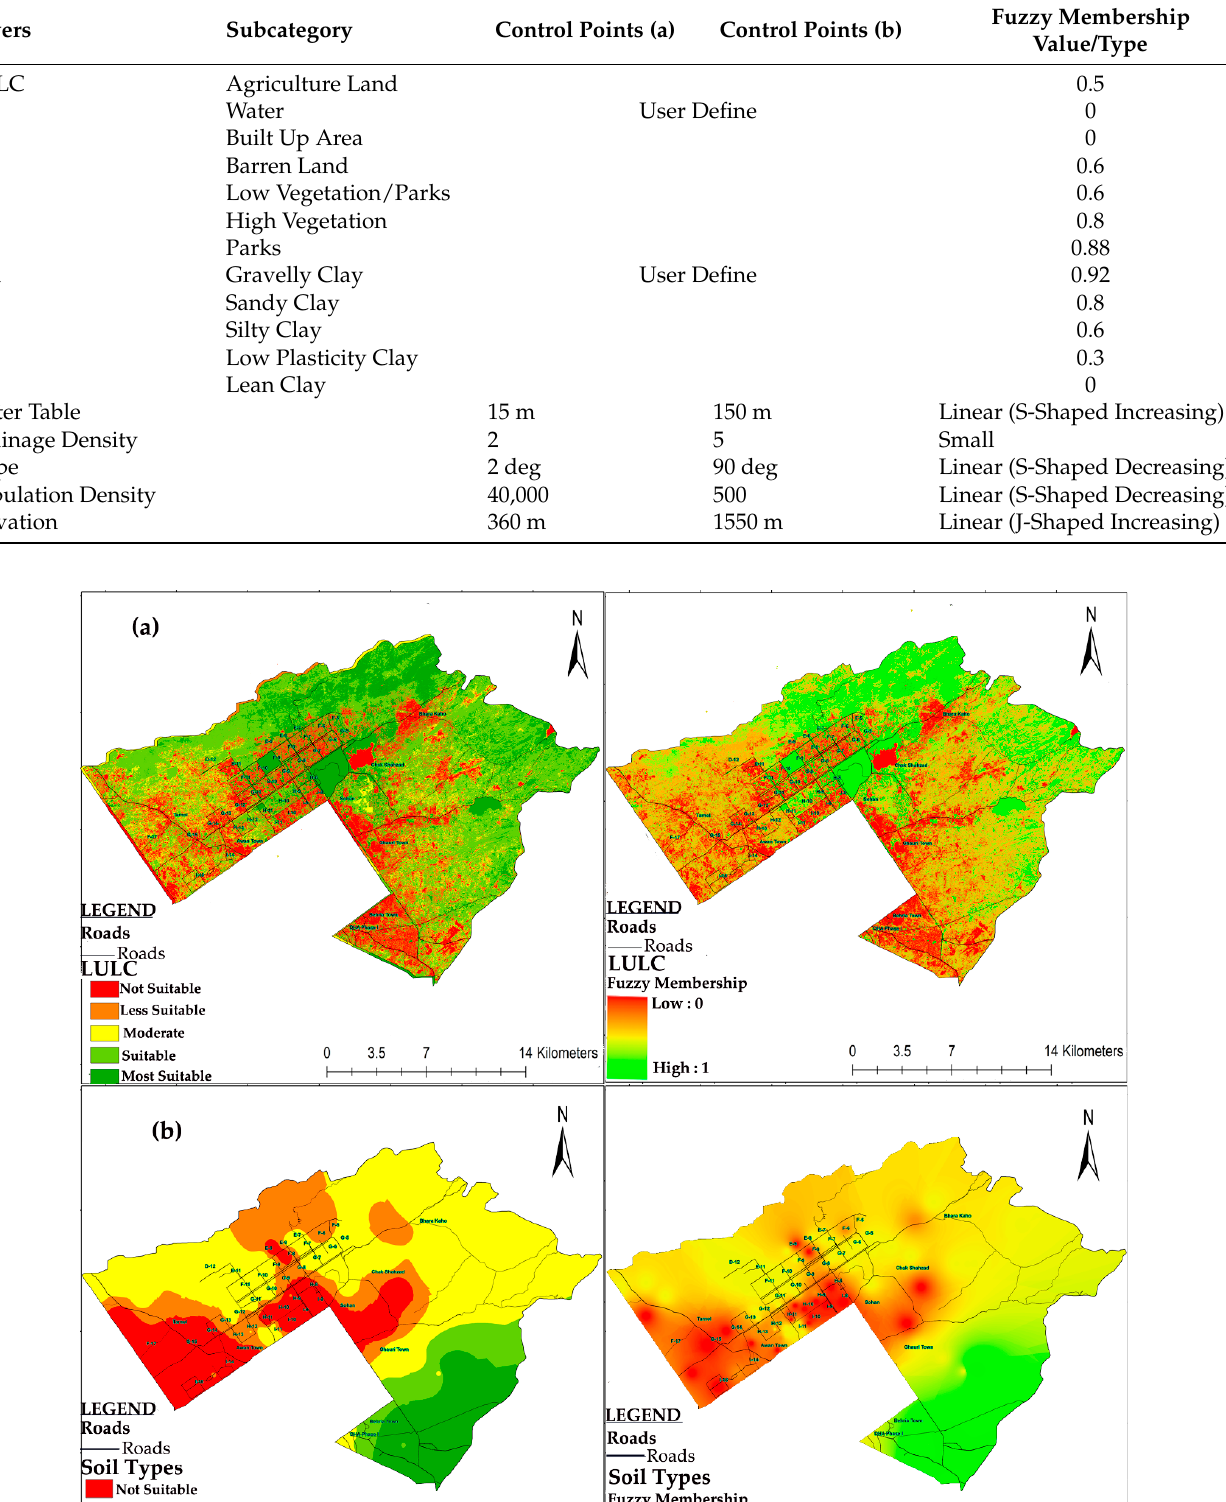
Table 8. Fuzzy set memberships function with controls points used for natural aquifer recharge.